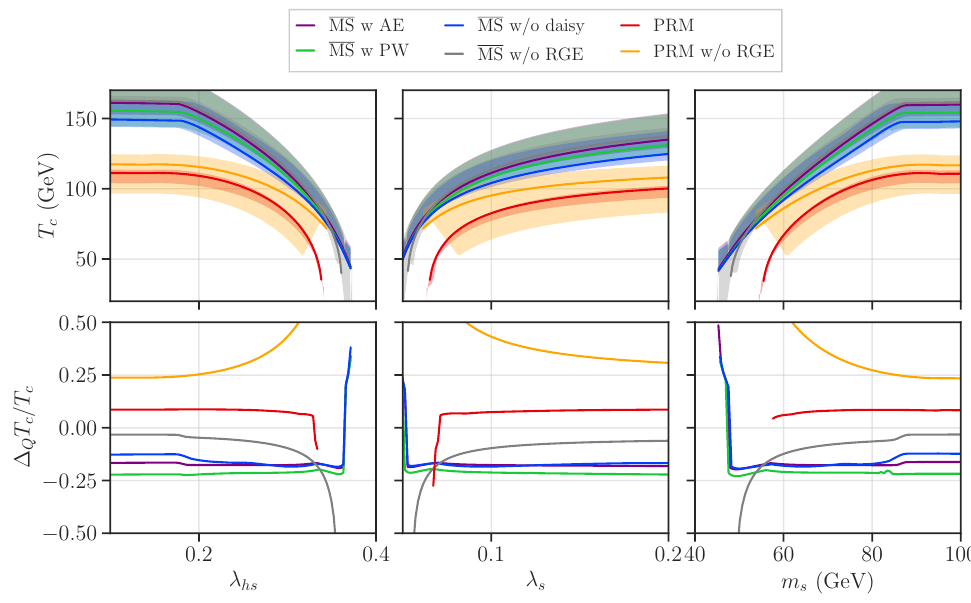
Figure 8 . Similar to figure 5, but for the renormalisation scale dependence in the MS scheme and PRM method found by varying the renormalisation scale from Q = T/ 2 to 2 πT by solving eq.